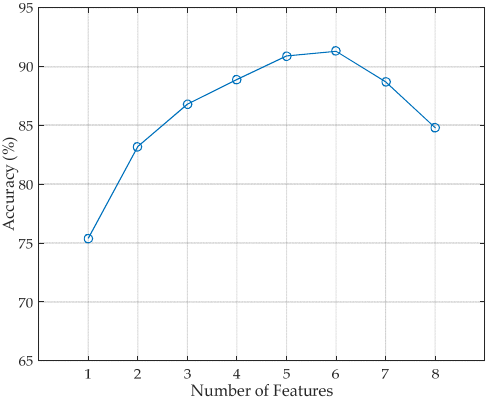
Figure 9. Impact of different numbers of features.